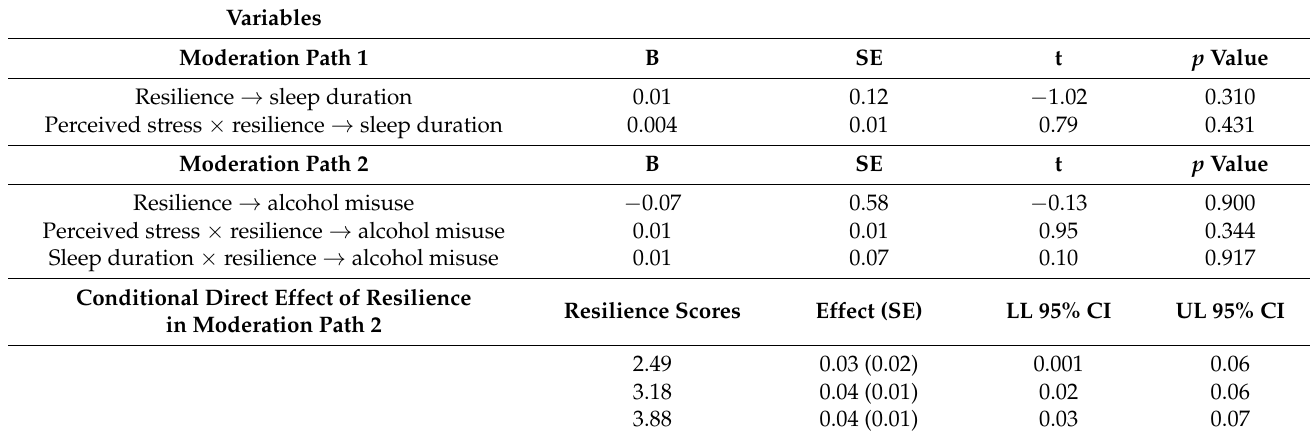
Table 13. Model 4 moderation